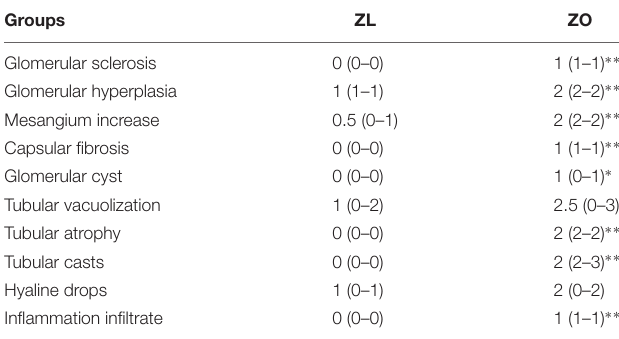
TABLE 2 | Histopathological results in male Zucker lean (ZL) and obese (ZO) rats at 8 months old. Groups